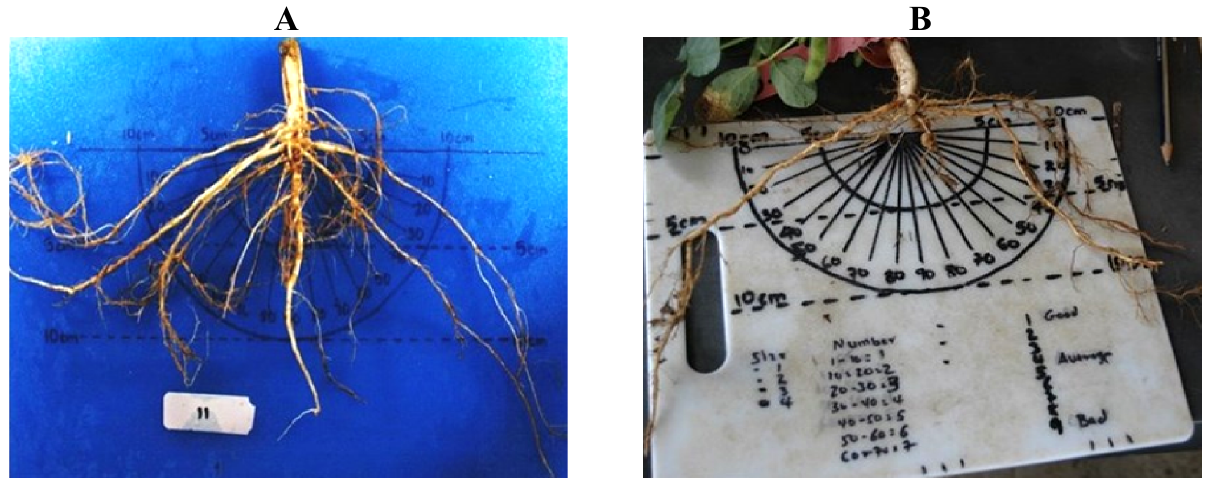
Figure 3. Images of the isolated and cleaned soybean roots together with root architectural angle measurement with a 180° protractor sketched board. ( A ) Root angle measurement of cultivar Prima 2000 representing an intermediate root angle genotype and ( B ) root angle measurement of cultivar A5409RG, which represents the shallow root angle genotype.